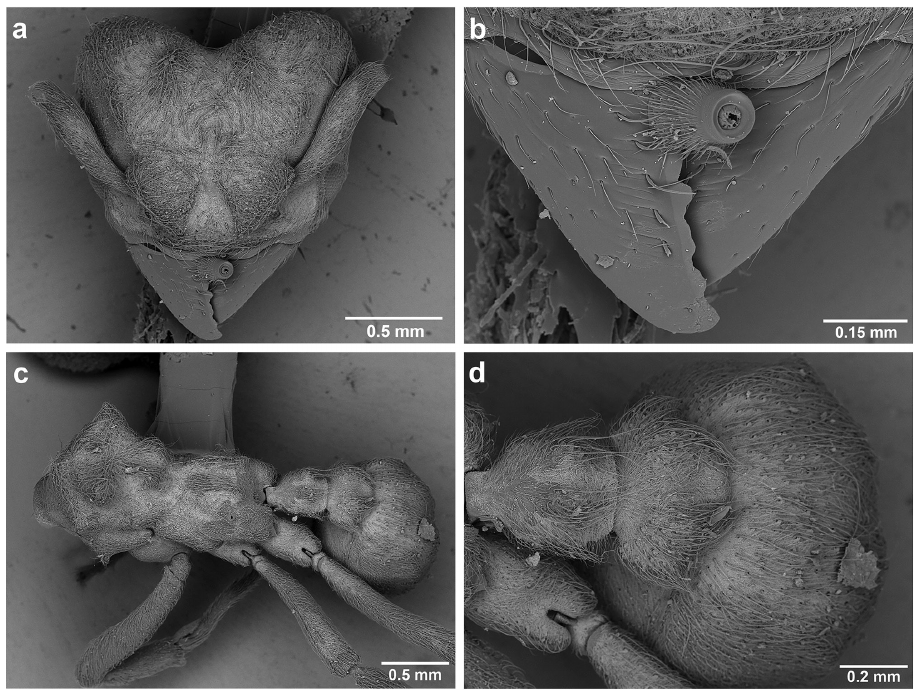
large, convex, 18 ommatidia across largest diameter. Frontal lobe as in worker, anten- nal scape not reaching posterior cephalic corner. Mesosoma. Scutum in dorsal view with notauli and median mesoscutal line re- duced. Parapsidal lines faint, slightly curved. Scutellum in dorsal view narrowing pos- teriorly, posterior notch shallow. Propodeum with two low, reduced denticles. Metasoma. First tergite of gaster with lateral carinae strongly developed, dorsal carinae absent, anteromedian groove distinct in dorsal view. S. lutzi male. Measurements in mm: HWe 0.9 HW 0.74 IFW1 0.27 IFW2 017 HL1 0.7 SL 0.74 EL 0.29 Om 30 EW 0.13 WL 1.74 PL 0.4 PPL 0.22 GL 1.4 HFL 1.67 PW 0.80 IOD 0.58 FWg 5.21 HWg 3.55 CI 128 FLI 30 SI 83 OI 32 [N=1] Head in full-face view longer than broad (CI=128). Eyes large (OI=32), 30 om- matidia across largest diameter. Preocular carina extending posterior to median ocel- lus, medially curved before fading. In dorsal view scutum with notauli well developed, mesoscutal line distinct, with dark-brown reticulation, best seen in frontodorsal view. Groove between axillae with one transverse, short costa medially. Propodeum devoid of protuberances or carinae except for spiracular tubercles. Petiole with weak lateral carinae; postpetiole simple, smooth, without denticles or carinae. S. lutzi geographic range. Guyana. Map: Figure